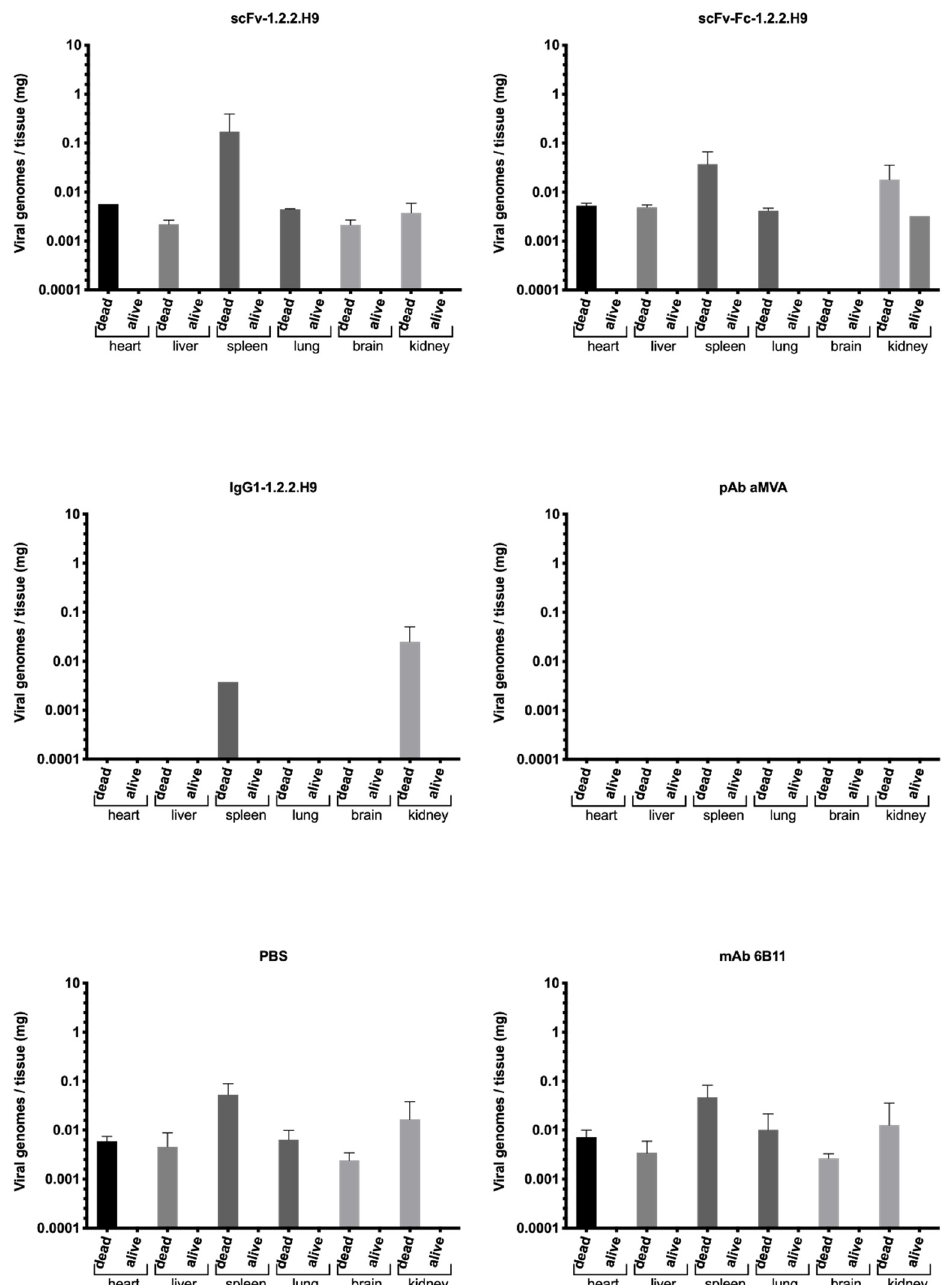
Figure 12. Concentration of the VACV DNA in different organs of mice after the challenge of VACV Munich 1. The mean of the viral load of sacrificed vs. surviving mice is shown for each treatment group.